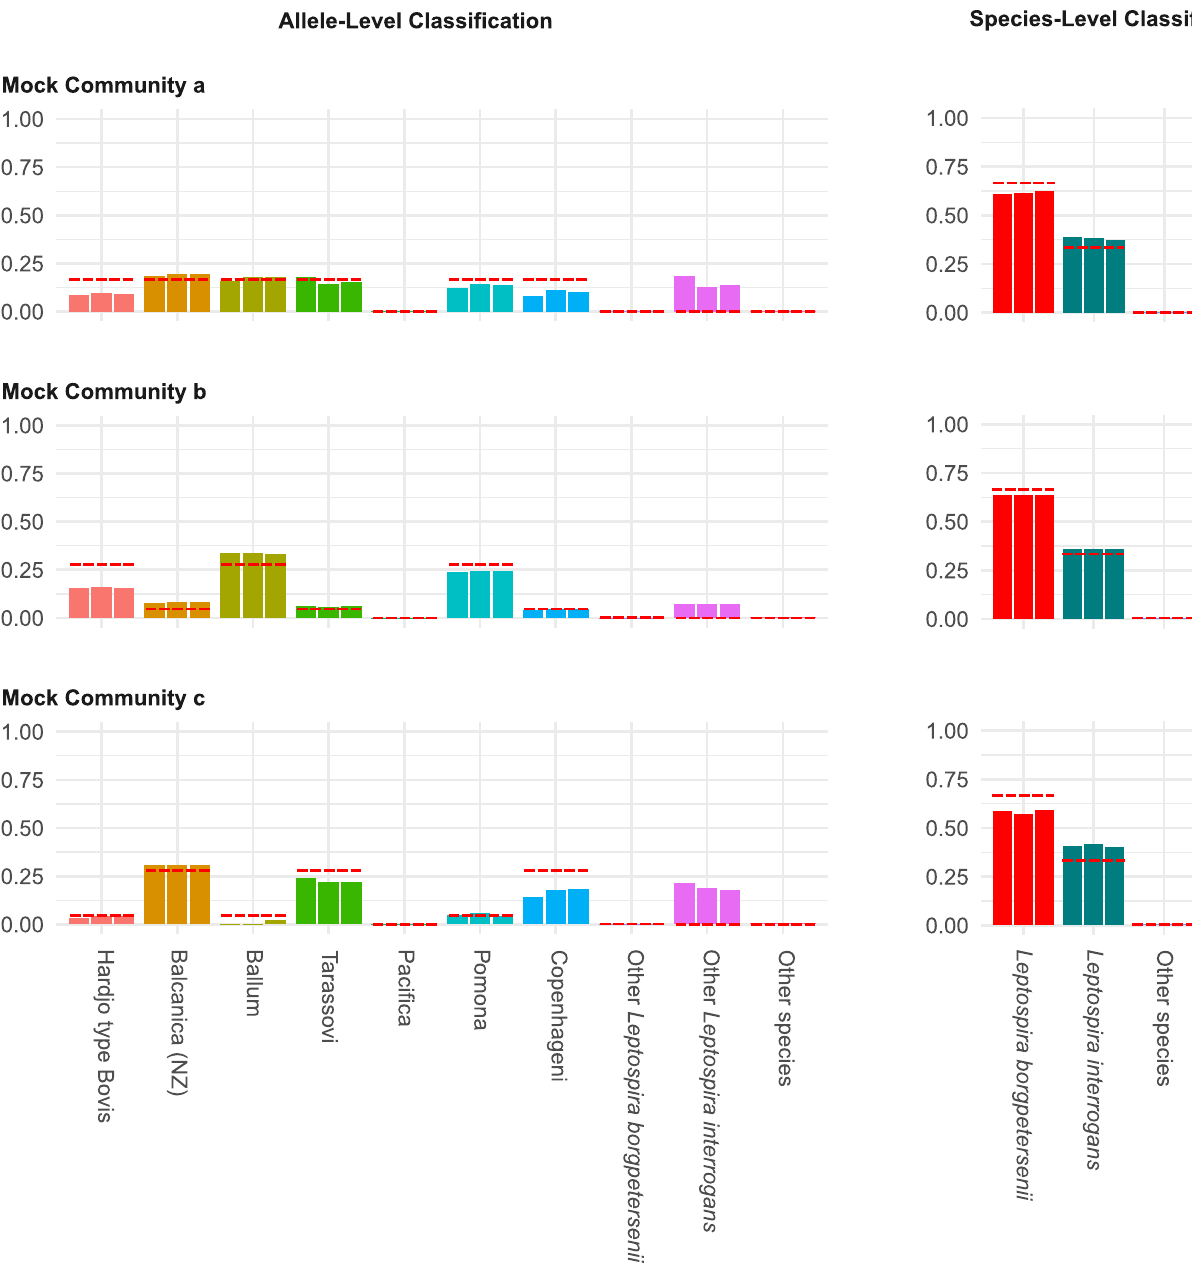
represent L . borgpetersenii sv. Balcanica, one endemic to New Zealand and the other found overseas. Furthermore, while the application of this method is good for disease surveillance and detection, it does not quantify the full biodiversity of Leptospira species i.e. the low-viru- lence subclade P2 or the saprophytic species from subclades S1 and S2 are not detected as the